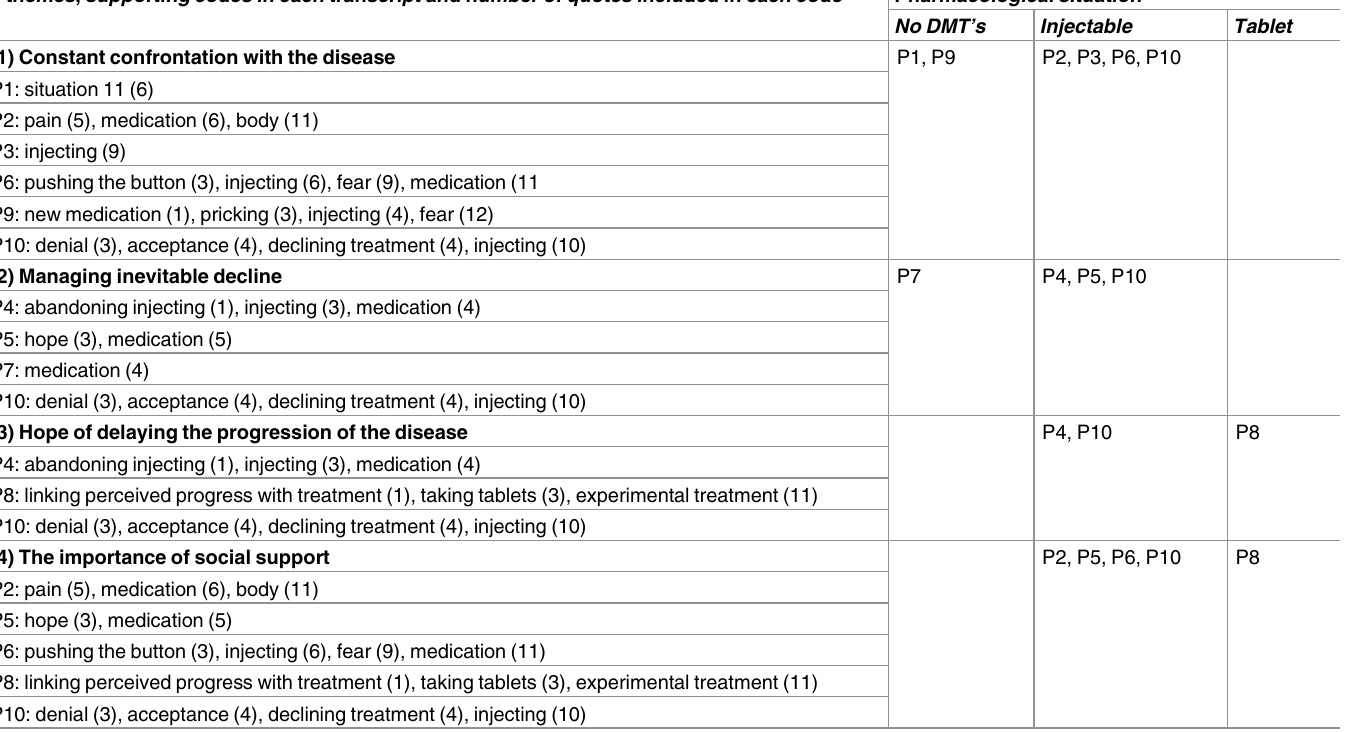
Table 2. Occurrenceof themes in the